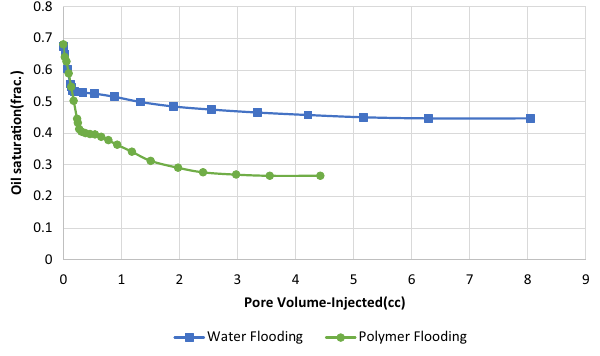
Fig. 10 Residual oil saturation for water and polymer flooding